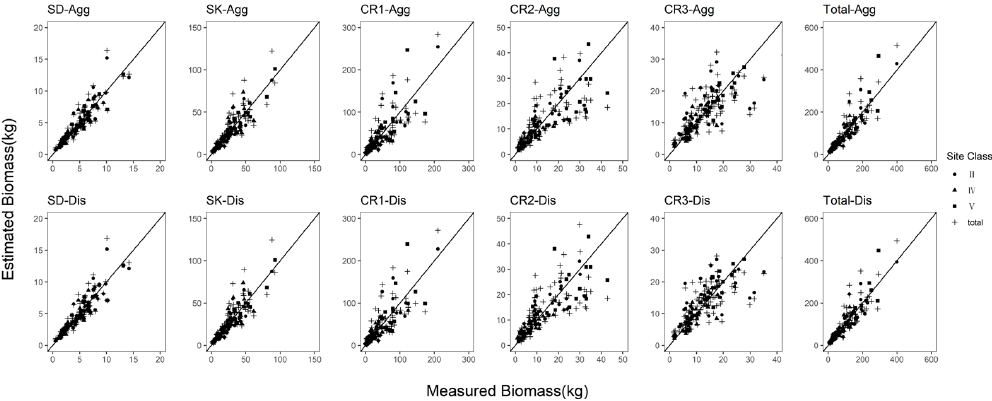
Figure 4. Comparison of each component and total biomass for the additive model and the disaggre- gated model at different site classes.